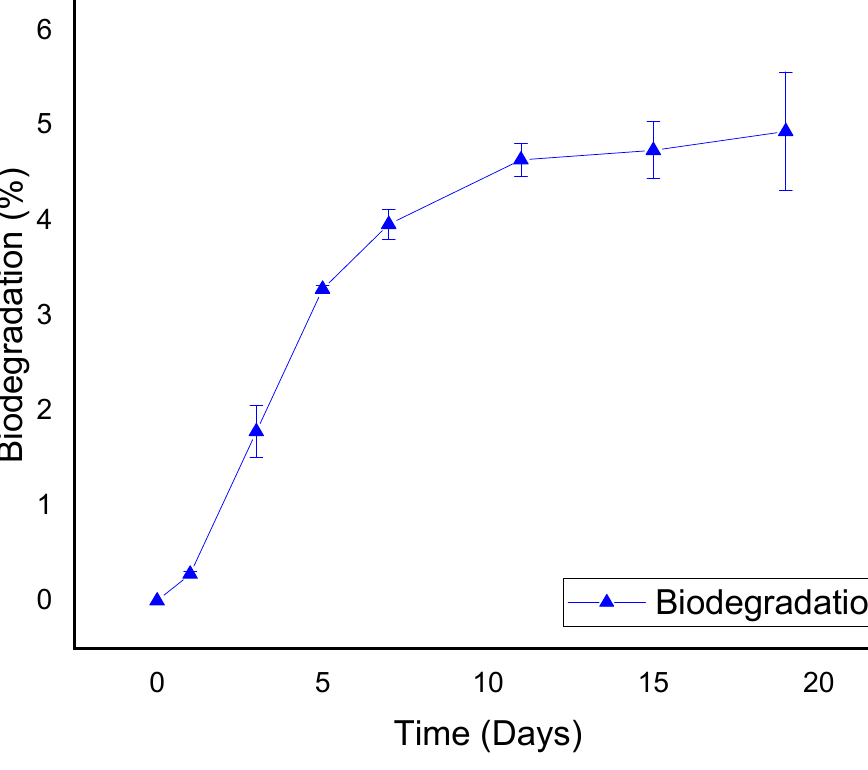
Figure 2. Percentage of rubber degradation.